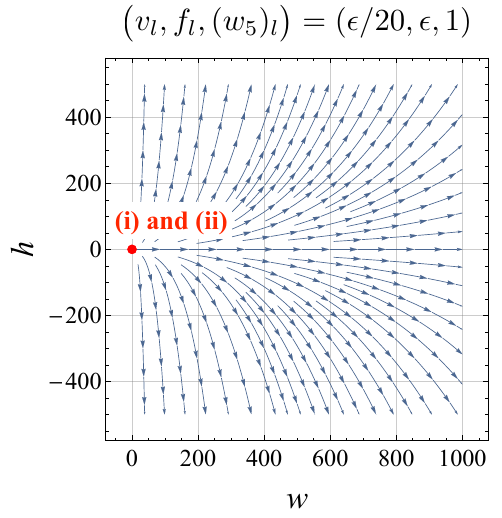
Figure 5 . RG (cid:13)ow of the parameters w and h with (cid:12)xed values of f and w 5 ( (cid:15) = 1). class determined only by non-conserved order parameters. Here, the internal-momentum loop dominated by the CMW (the wavy lines in (cid:12)gure 7) is suppressed near the (cid:12)xed point (iv), so that not only n but also n 5 do not a(cid:11)ect the dynamic universality class.